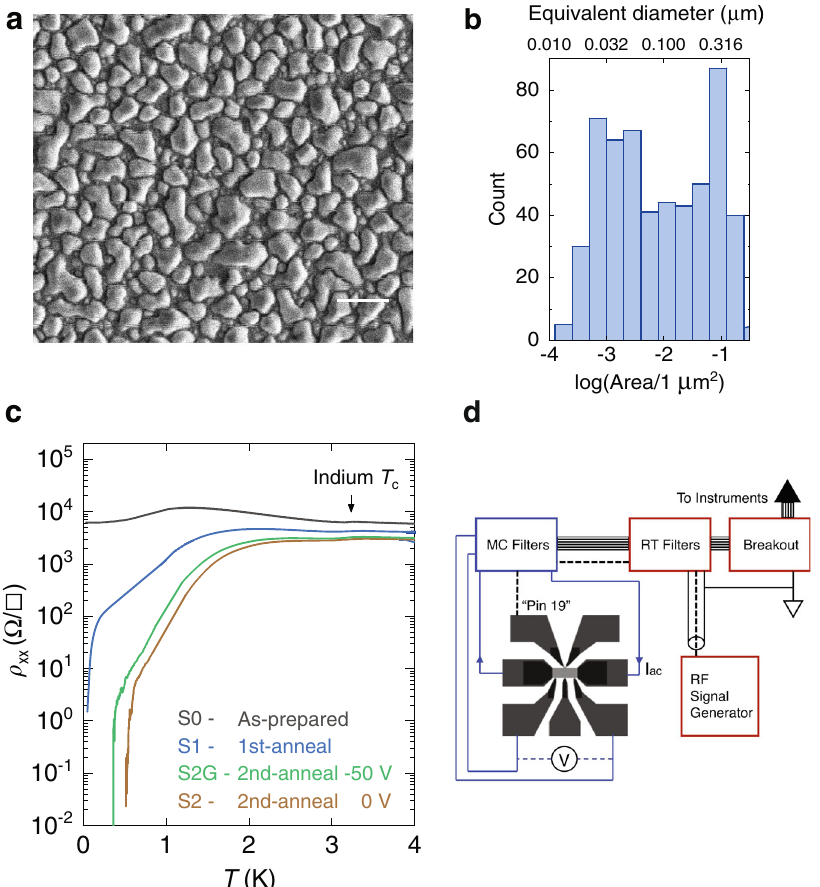
Fig. 1 Sample characterization. a Scanning electron microscopy (SEM) micrograph of the InO x /In sample. Bright grains on the foreground are metallic indium, while dark background that lies uniformly underneath is weakly-insulating amorphous InO x . Note the existence of In grains of all scales including the interstitial ones. Scale bar at lower right corner indicates 1 μ m. b Histogram of logarithm of grain area, extracted from the SEM data using a clustering algorithm (see Supplementary Fig. 1), shows a broad distribution of grain size. The top axis shows equivalent grain diameter. Limitation of image resolution cuts off the distribution below ~0.01 μ m. c Zero- fi eld resistivity as a function of temperature (smoothed for visibility). Superconducting transition temperature ( T c ≈ 3.4 K) of indium is indicated by the arrow where resistivity drops by around 10% for all anneal stages. As sample anneals, resistivity decreases and a global superconducting ground state emerges. d Schematics showing resistance measurement and coupling of RF signal to the sample. See “ Methods ” for fi lter speci fi cations. The RF signal generator generates at output power 0 dBm (1 mW) unless otherwise noted. ‘ Breakout ’ is a room-temperature breakout box for measurement wires, where the shielding serves as a common ground for the entire measurement